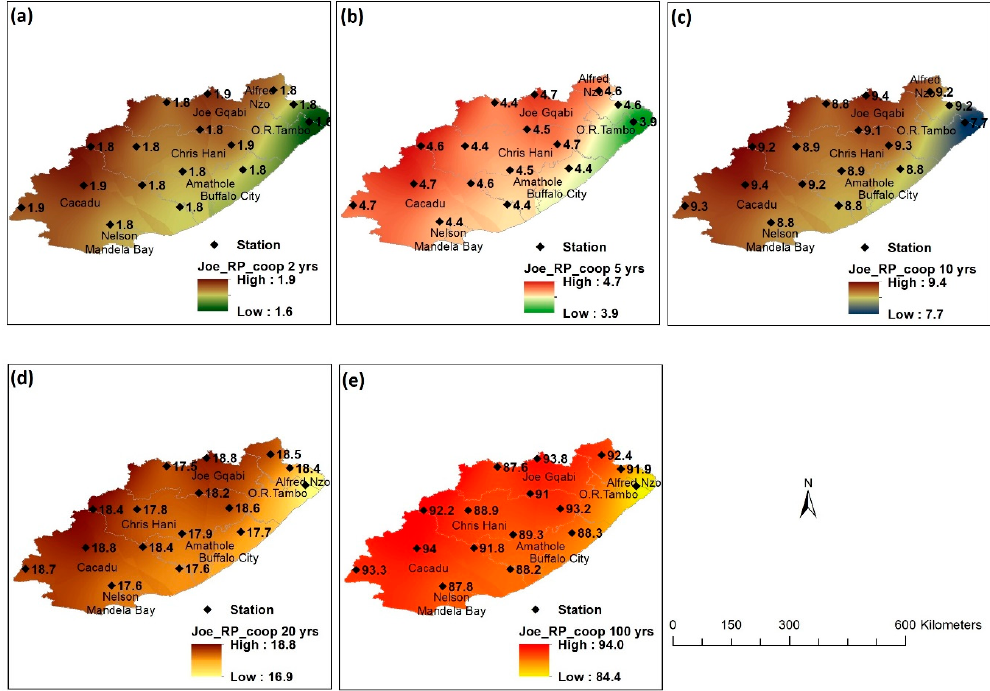
Figure 8. Spatial distribution of cooperative return period corresponding to ( a ) 2-year, ( b ) 5-year, ( c ) 10-year, ( d ) 20-year, and ( e ) 100-year univariate risks of return periods based on the Joe Copula.